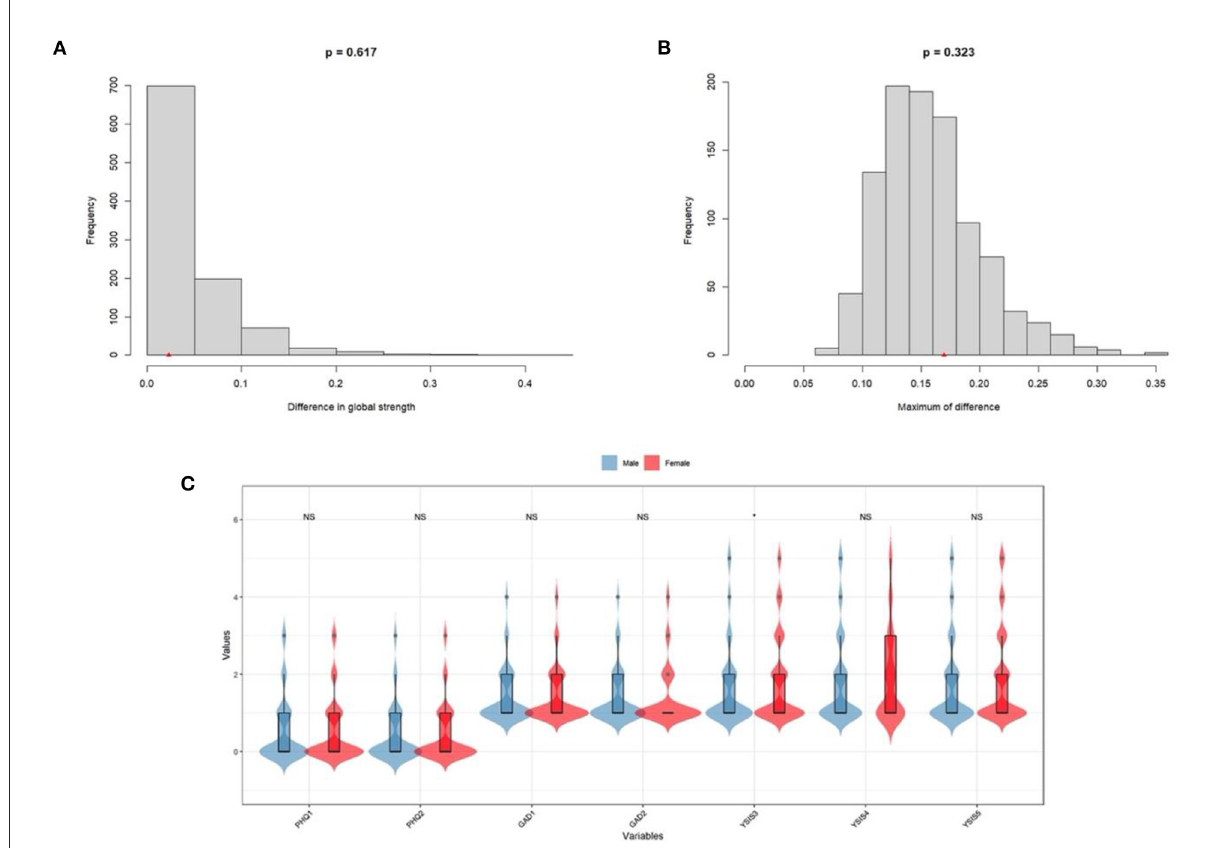
FIGURE3 Network comparison between male elderly and female elderly. (A) Global strength. (B) Edge weights. (C) Mean scores on items between male elderly and female